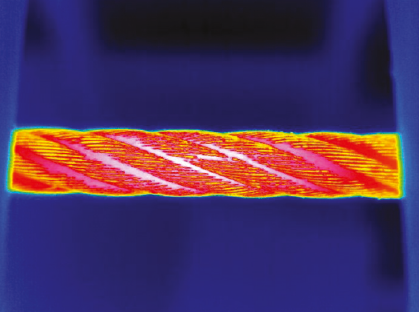
Figure 5: Original infrared